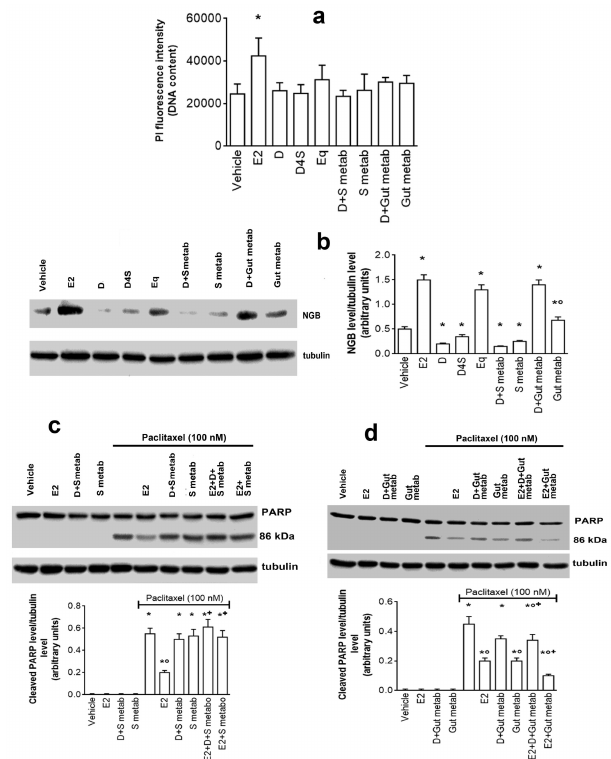
Figure 6. Physiological outcomes of D in mixture with its metabolites. ( a ) Analyses of cellular DNA content obtained from PI assay, Western blot (left) and densitometric analyses (right) of NGB levels ( b ) in MCF-7 cells. ( c , d ) Western blot (up) and densitometric analyses (bottom) of PARP-1 cleavage in MCF-7 cells. The MCF-7 cells were treated for 24 h with either vehicle (DMSO) or E2 (10 nM) or D, D4S or Eq (1 µ M); some samples were treated with all the sulfate metabolites (D4S, D7S and DDS, 1 µ M each) or all the gut metabolites (Eq and O-DMA, 1 µ M each) in presence or absence of D (1 µ M). Data are mean ± SD of three di ff erent experiments. (*) p < 0.001 was calculated with Student t test versus vehicle in ( a ). In b , data are the mean ± SD of five di ff erent experiments: p < 0.001 was determined with Student t test with respect to the vehicle (*) or to D-treated samples co-stimulated with metabolites ( ◦ ). In ( c , d ), data are the mean ± SD of three di ff erent experiments. p < 0.001 was determined with Student t test with respect to the vehicle (*) or Pacl-treated ( ◦ ) or E2 untreated samples co-stimulated with the metabolites ( + ). E2: estradiol; NGB: neuroglobin; DMSO: dimethyl sulfoxide; D: daidzein; Eq: equol; O-DMA: o-desmethylangolesin; D7S: daidzein-7-sulfate; D4S: daidzein-4 (cid:48)